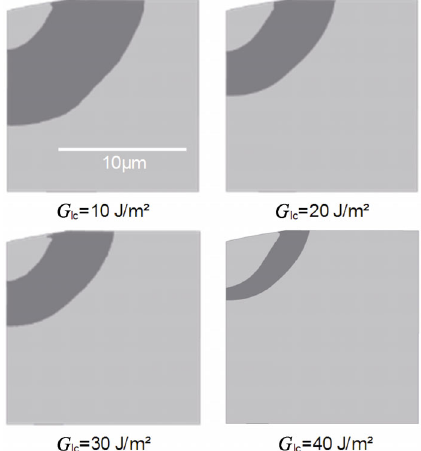
Influence of residual stress on the fracture toughness determined by instrumented indentation for a sample without residual stress and with compressive residual stress of 100 and 200